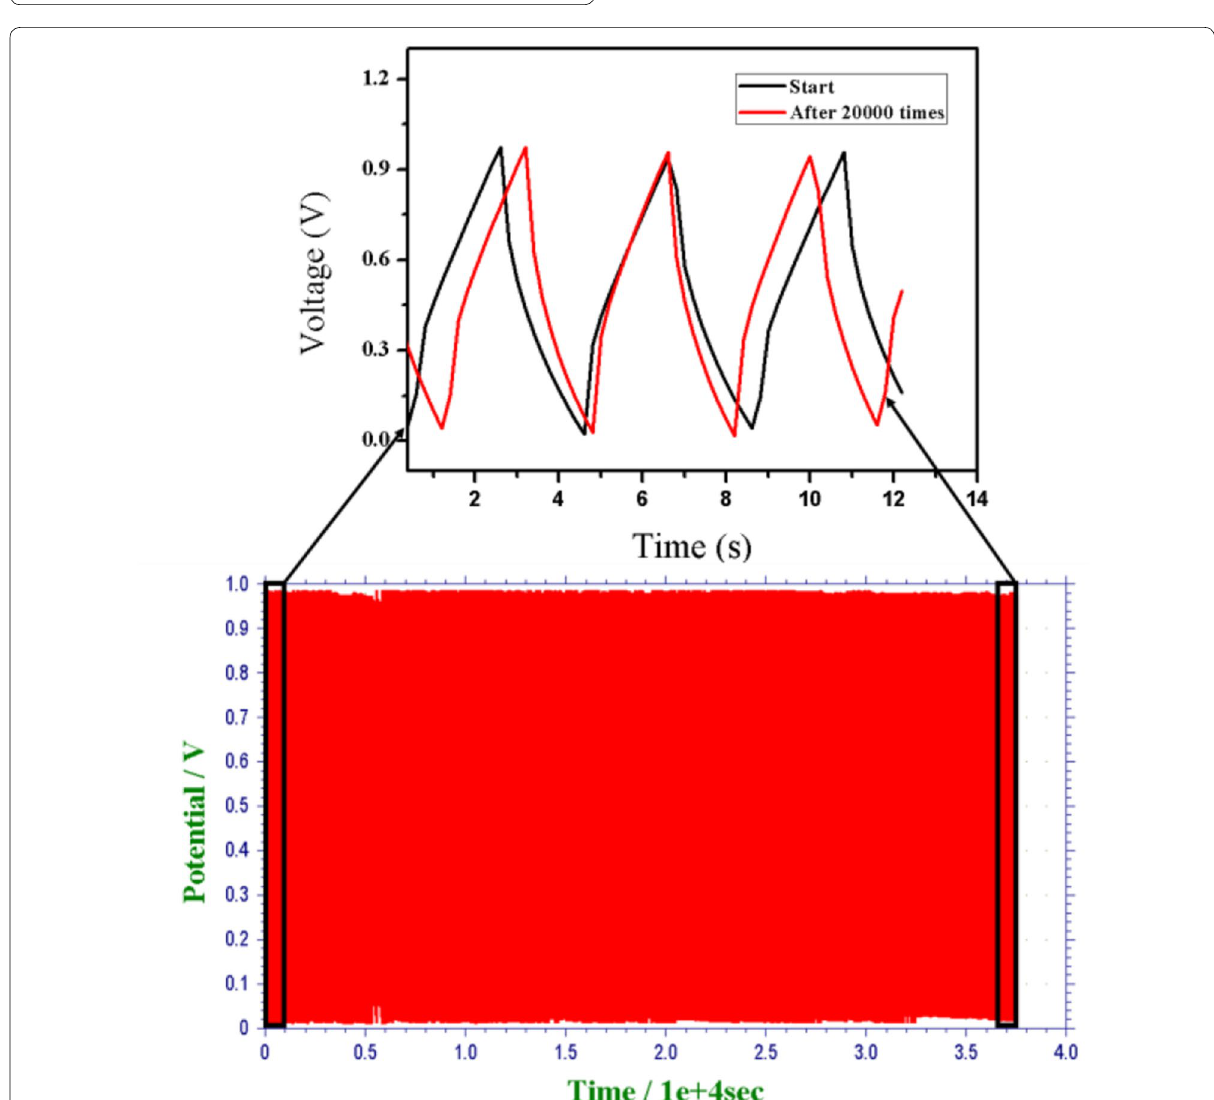
Fig. 8 Galvanostatic charging–discharging curves and its cycle life (20,000